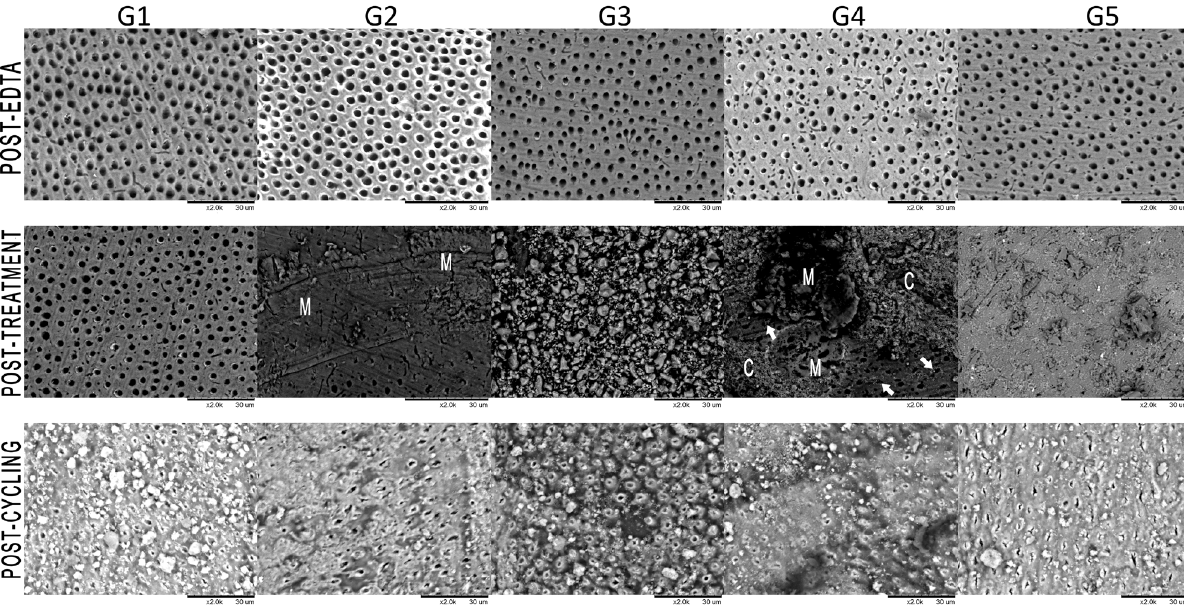
Figure 4- Representative micrographs of treatments for each group and evaluation moment (2000x magnification). (M) Melting; (C) Crystal-like layer. Arrows indicate crystals deposition inside dentin